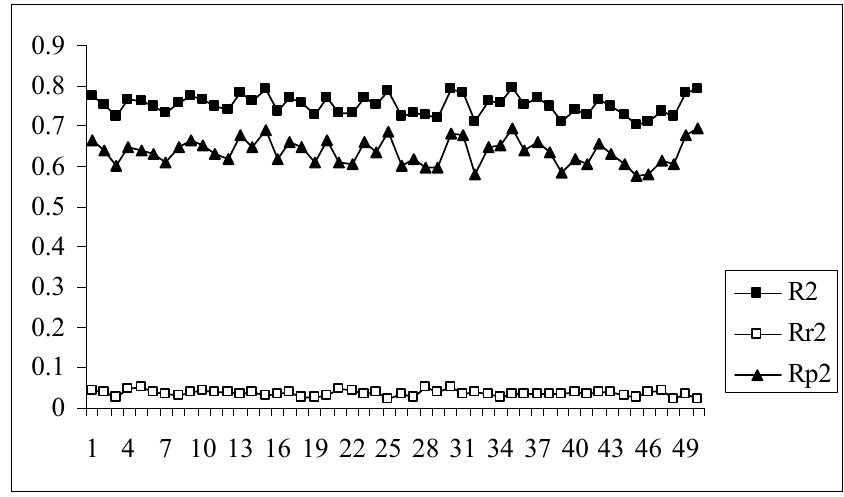
Figure 12. Comparative plots of R 2 , R r2 and R p2 values of 50 models (data set